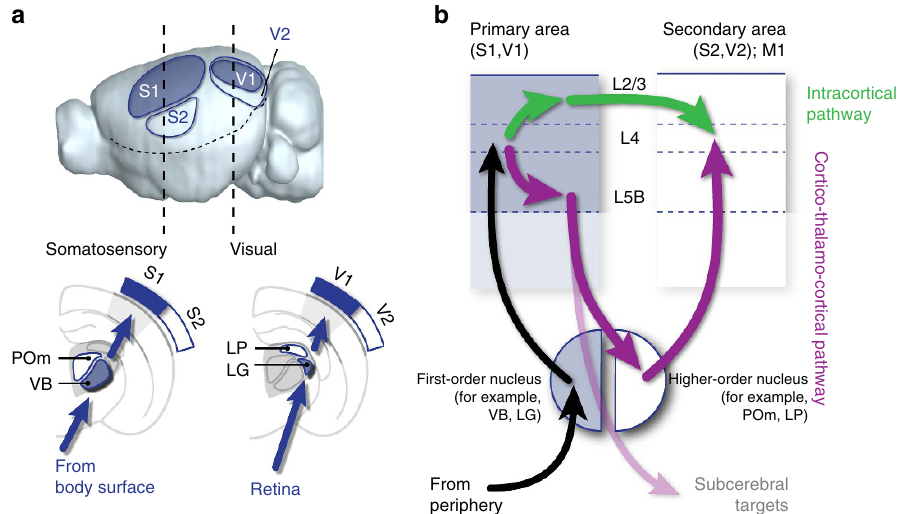
Figure 2 | Cortical information flow. ( a ) Exteroceptive, first-order thalamic nuclei (filled in blue) project to primary cortical areas (e.g.S1, V1). Higher-order thalamic nuclei and secondary cortical areas are outlined in blue. POm: posteromedial thalamic nucleus; LG: dorsolateral geniculate nucleus; LP: lateroposterior nucleus; VB: ventrobasalis nucleus. ( b ) Two main pathways allow inter-areal communications: an intracortical pathway (green) and a cortico-thalamo-cortical pathway (purple), originating from L5B corticospinal neurons and which transits through higher-order thalamic